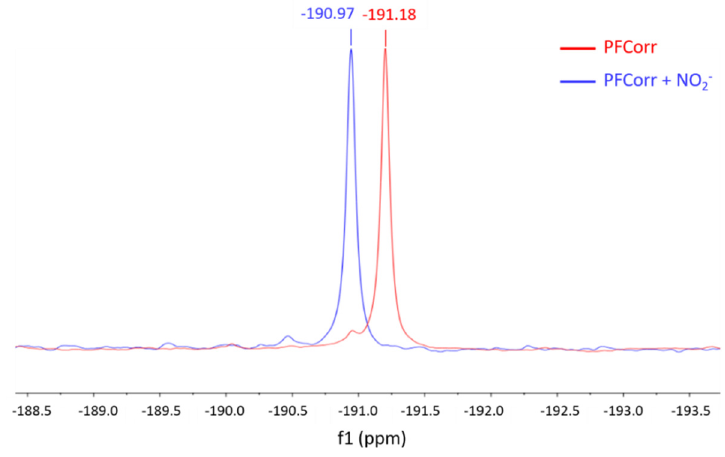
Figure 4. The 31 P NMR spectra in CDCl 3 of PFCorr before (red) and after (blue) the addition of NO 2— ions.